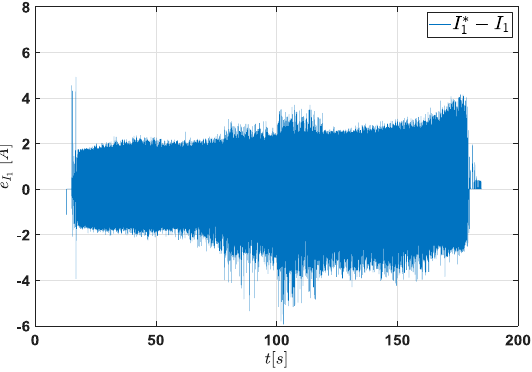
Figure 20. Current error response of phase 1 using STSMC.